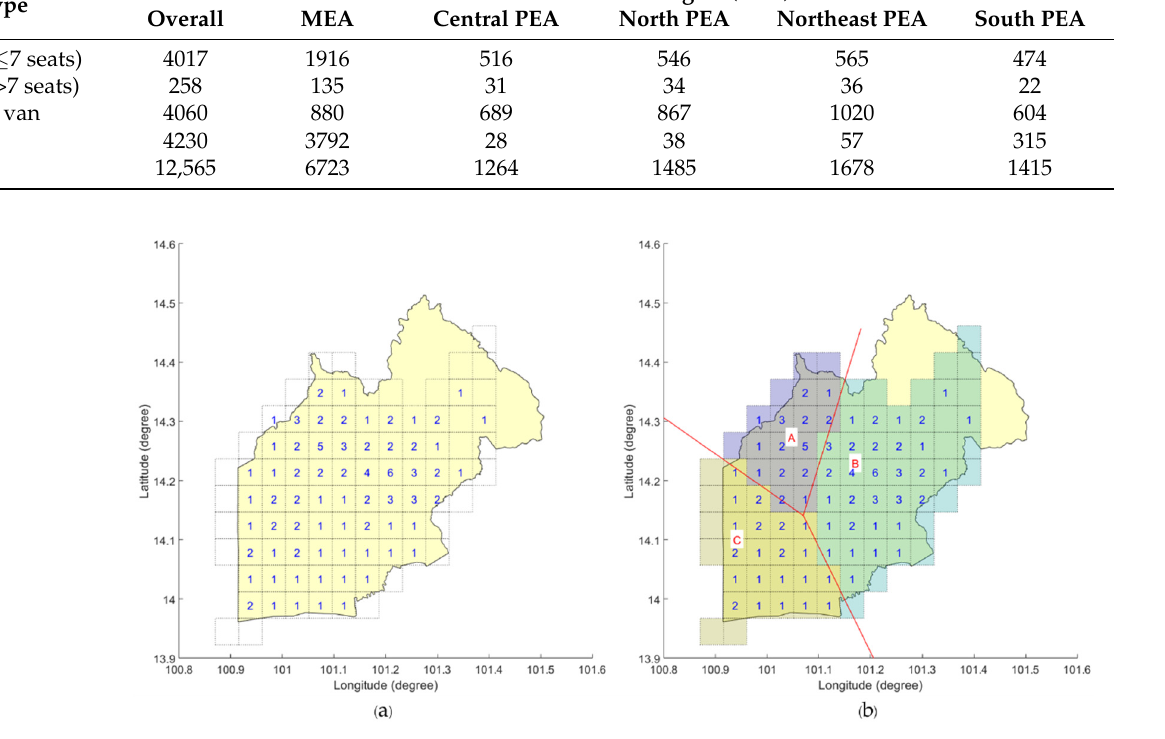
Figure 10. ( a ) Allocation of public fast chargers based on energy consumption and ( b ) public fast chargers grouped with substation A, substation B, and substation C by using the Voronoi diagram.